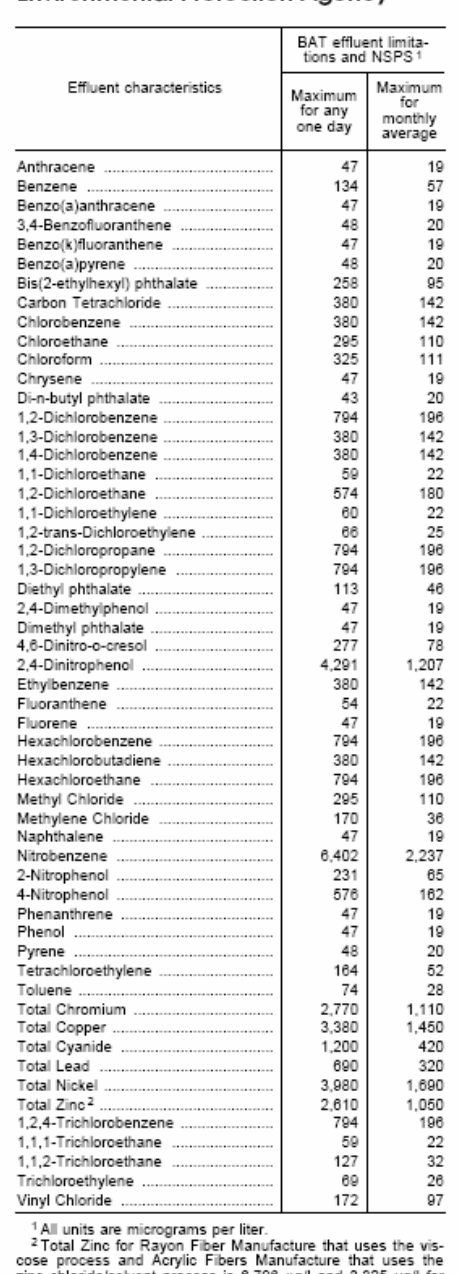
Table 7. Pretreatment standards for manufacturers of organic chemicals, plastics, and synthetic fibers [